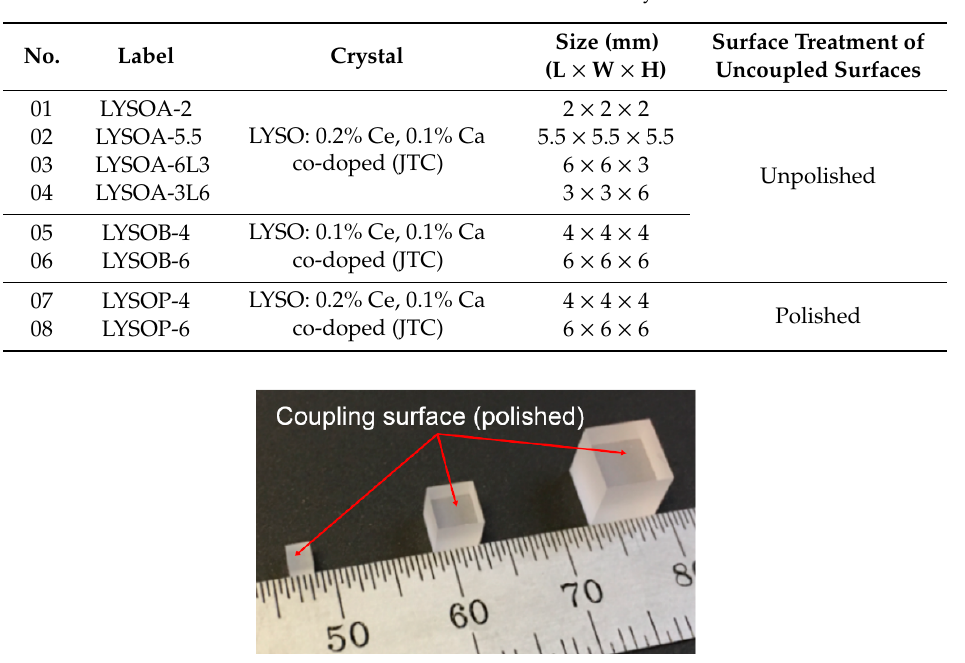
Table 2. Parameters of the LYSO cube crystals.